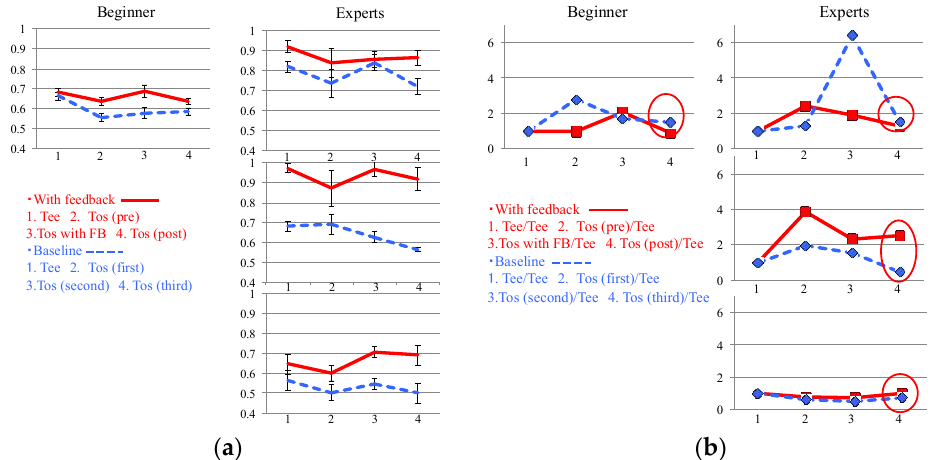
・ With feedback 1. Tee/Tee 2. Tos (pre)/Tee 3.Tos with FB/Tee 4. Tos (post)/Tee ・ Baseline 1 . Tee/Tee 2. Tos (first)/Tee 3.Tos (second)/Tee 4. Tos